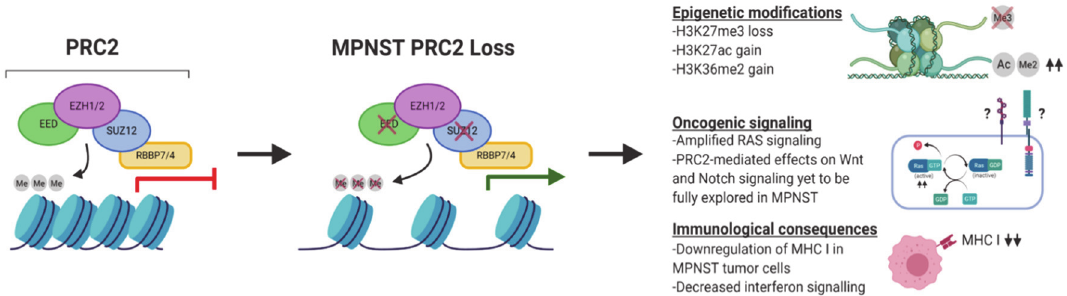
Figure 3. PRC2 structure and consequences of its loss in MPNST. Loss of PRC2 via EED or SUZ12 loss in MPNSTs leads to loss of tri-methylation of histone H3 lysine 27 (H3K27me3) and other potential epigenetic modifications. In addition, PRC2 loss can have a wide variety of consequences on oncogenic signaling and immune surveillance and response.